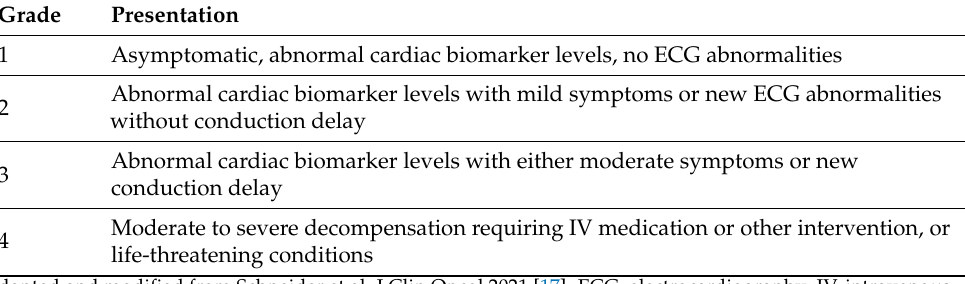
Table 2. American Society of Clinical Oncology classification of ICI-related cardiovascular